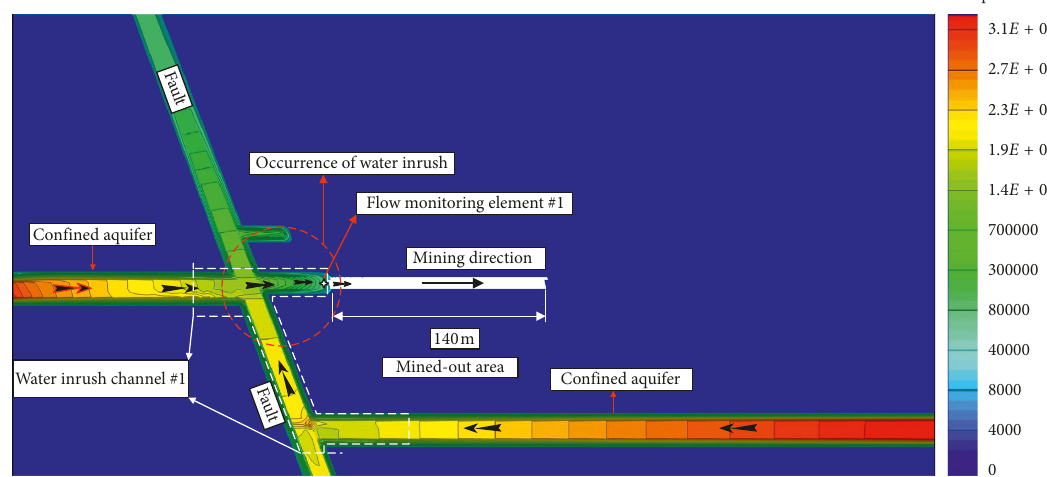
Figure 9: Pore pressure distribution when mining width reaches 170m.